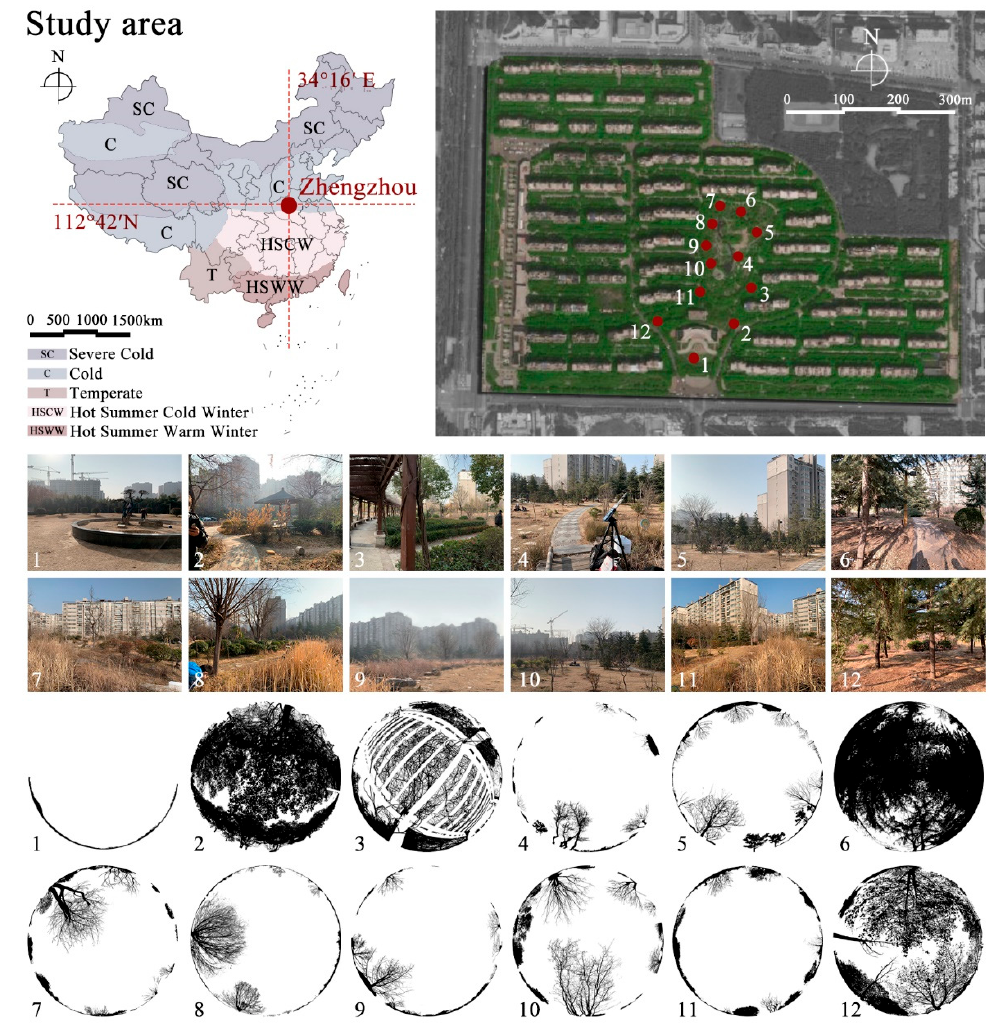
Figure 2. Study site locations and landscape characteristics of these sites.